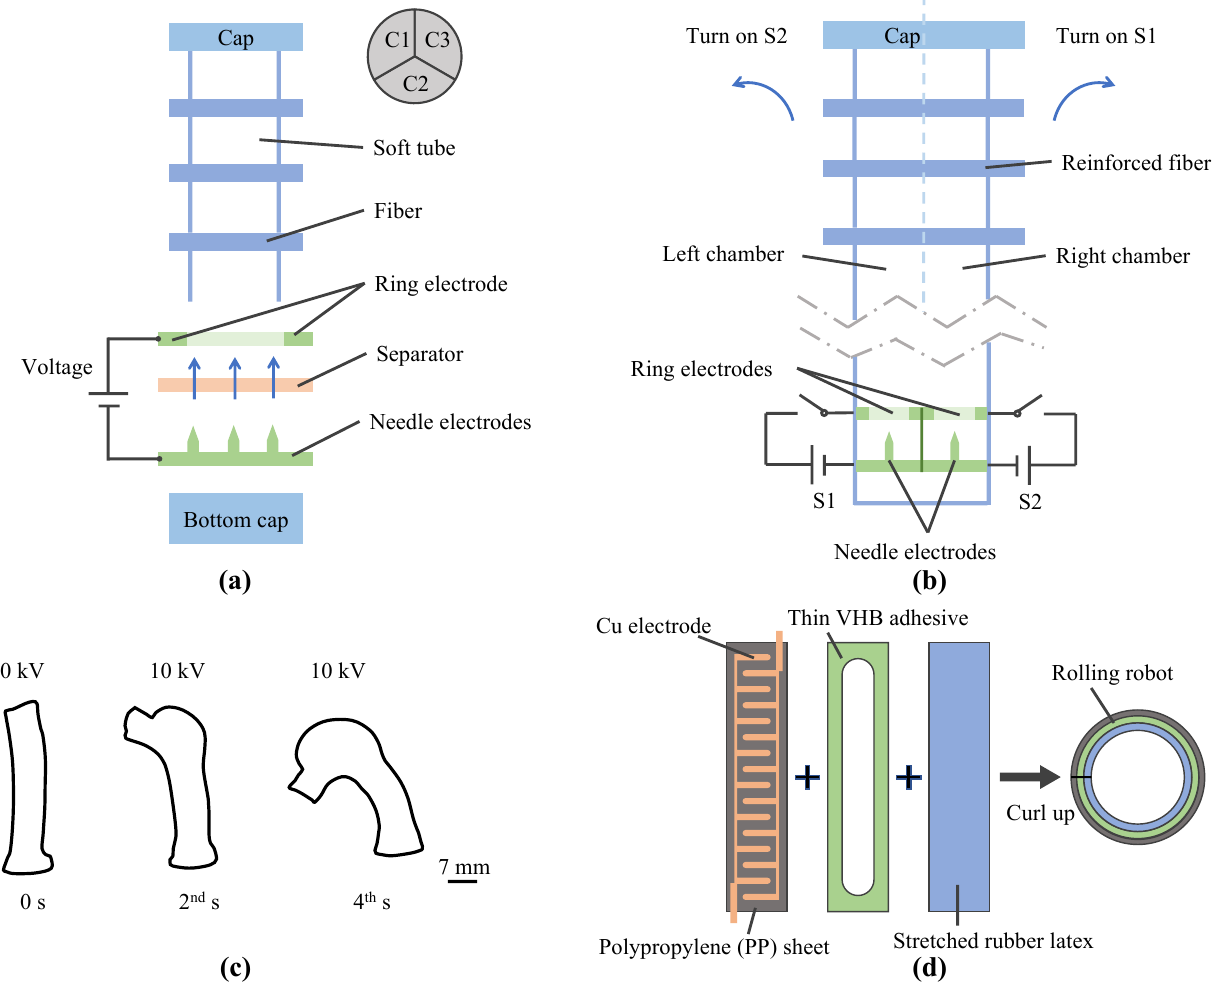
Figure 7. Soft robots driven by EHD pumps. ( a ) Soft fiber-reinforced bending finger [52]. ( b ) Soft finger with bidirectional motion [63]. ( c ) Eccentric actuator [142]. ( d ) Fluidic rolling robot